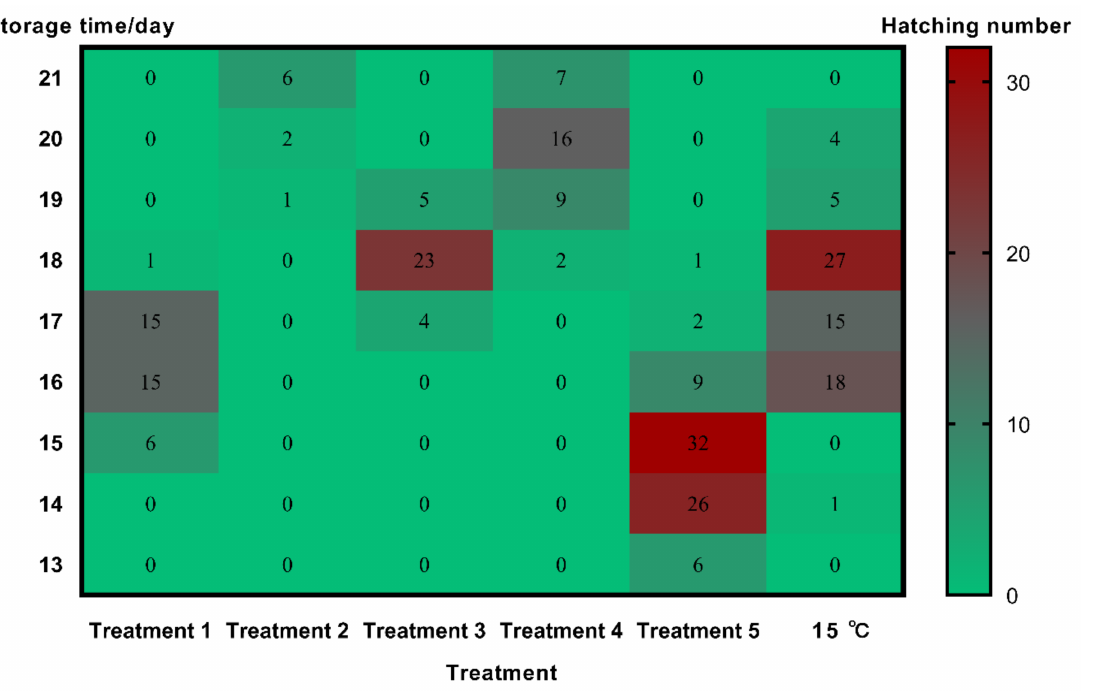
Figure 7. Heat map of the storage time and hatching number of each treatment.